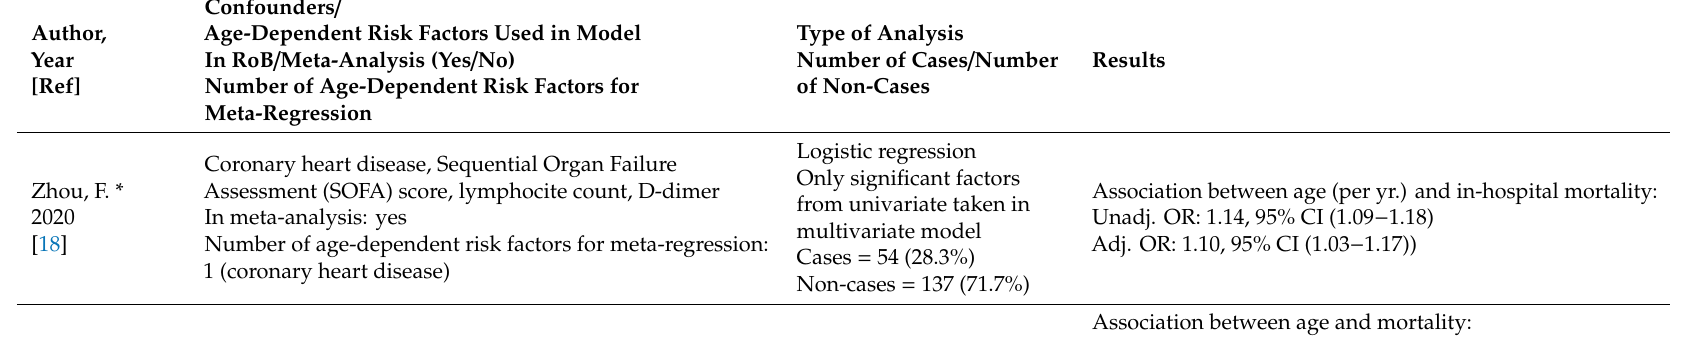
Table 4. Characteristics and results of included studies using death as